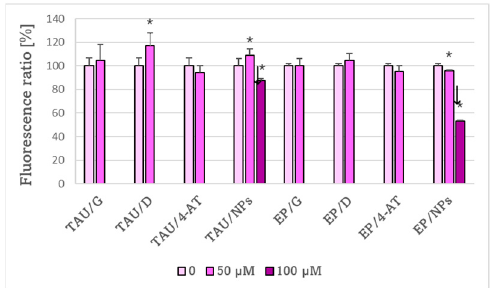
Figure 11. Effect of antioxidants on the level of lipid peroxidation in TAU and EP cells. G, genistein; D, delphinidin; 4-AT, 4-amino-TEMPO; NPs, nanoparticles. * p < 0.05 compared to cells not treated with the antioxidant; ↓ p < 0.05, TAU cells compared to EP cells treated with the same concentration of antioxidant; n = 3.